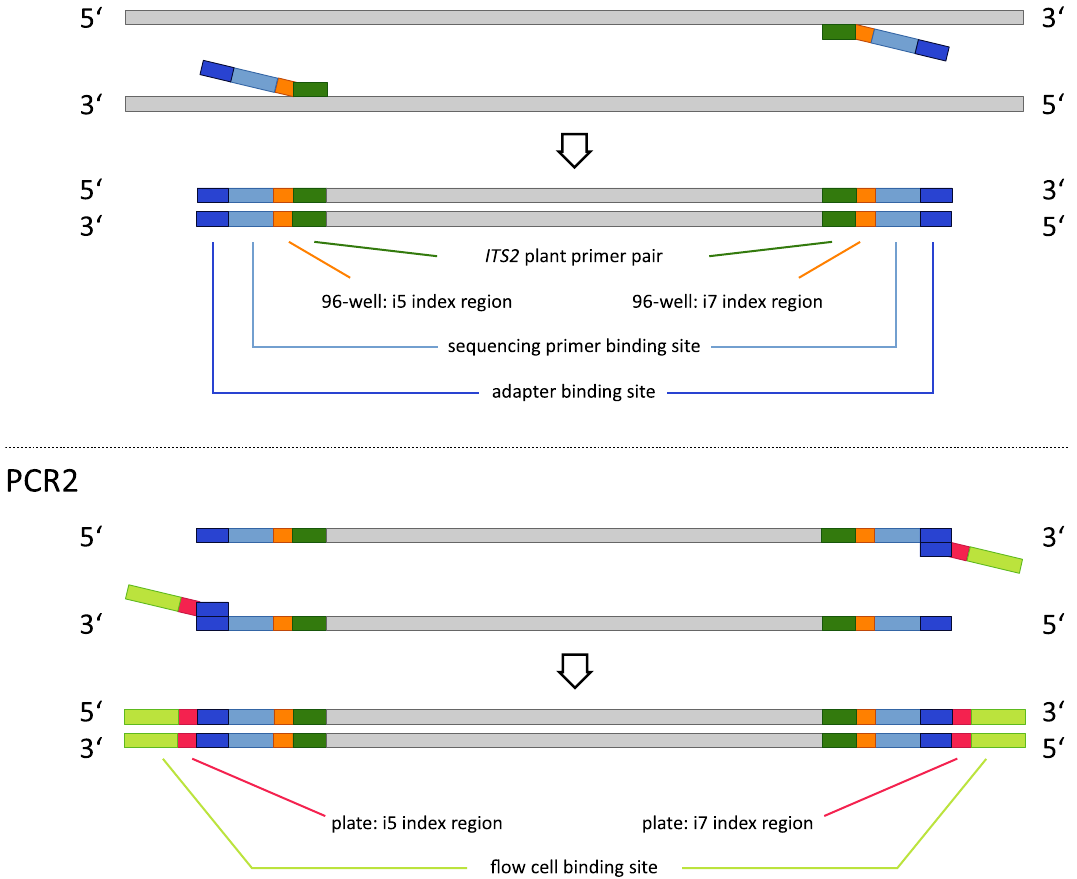
Figure 1. NGS library preparation for the applied targeted amplicon NGS and nested metabarcoding approach comprising two consecutive PCRs. In PCR1, DNA fragments are amplified to which the following is attached: primers targeting the genomic region ITS2 , indexes to identify the 96 samples per plate (sample specific combination of i5 and i7 indexes), sequencing primer binding site, and the adapter binding site. In PCR2, additionally, specific combinations of indexes of i5 and i7 indexes for each plate are added as well as the binding site for the flow cell of the Illumina electrophoresis system QIAxcel with the QIAxcel DNA Screening Kit (both: Qiagen, Hilden, Germany), the method AM320 and an injection time of 30 s. Results were scored with the software QIAxcel ScreenGel v1.6.0.10 (Qiagen, Hilden, Germany). Samples showing the expected fragment length with a signal above 0.1 relative fluorescent units (RFU) were deemed to be positive. In a second PCR, all samples within a 96-well plate were additionally indexed by adding the Nextera adaptors (PCR2). Each of the 24 plates received its individual index combination comprising the i5 indexes [E/H/N/S] 502, 503, 505–508 and i7 indexes [H/N] 702–705 42 , finally resulting in 2,290 individual index combinations (Fig. S1). The 25 μl reaction volume of each PCR2 contained 5 μl template PCR product from PCR1, 1 μl bovine serum albumin (BSA) (10 mg/ml), 12.5 μl 2 × Type-it Mutation Detect PCR Kit (Qiagen, Hilden, Germany), 1.5 μl molecular grade water, and 2.5 μl of adapter 1 and 2 each (10 μM) (see Table S2 for adapter sequences). The thermal cycling scheme was as follows: 5 min at 95 °C followed by 8 cycles of 30 s at 95 °C, 30 s at 55 °C, 60 s at 72 °C and a final extension for 5 min at 72 °C. The separation and visualization of the PCR products on a QIAxcel system was done as described above. All individual dietary samples were then pooled into one sample per plate (‘plate sample’ Fig. S2), with the control samples undergoing no further analysis. The specific volume of each dietary sample in this pool depended on its RFU value: 25 μl (whole) reaction volumes were taken from samples with an RFU between 0.1 to 4.0, 10 μl from those with an RFU larger than 4.0 up to 6.0, and 5 μl from those ones with an RFU larger than 6.0. This resulted in 24 plate samples that were purified with the magnetic bead capture kit SPRIselect (method: left side selection) (Beckman Coulter, Inc., Brea, U.S.A.) following the manufacturer’s instructions, before sending them for sequencing. In the nested metabarcoding approach, the library consists of an inner (ID for one of the positions in the 96-wells) and an outer (plate ID) pair of index combinations (see Fig. 1). The outer pair of indexes corresponds to the standard unique dual index (UDI) combination, which is recognized by the sequencer as an index, while the